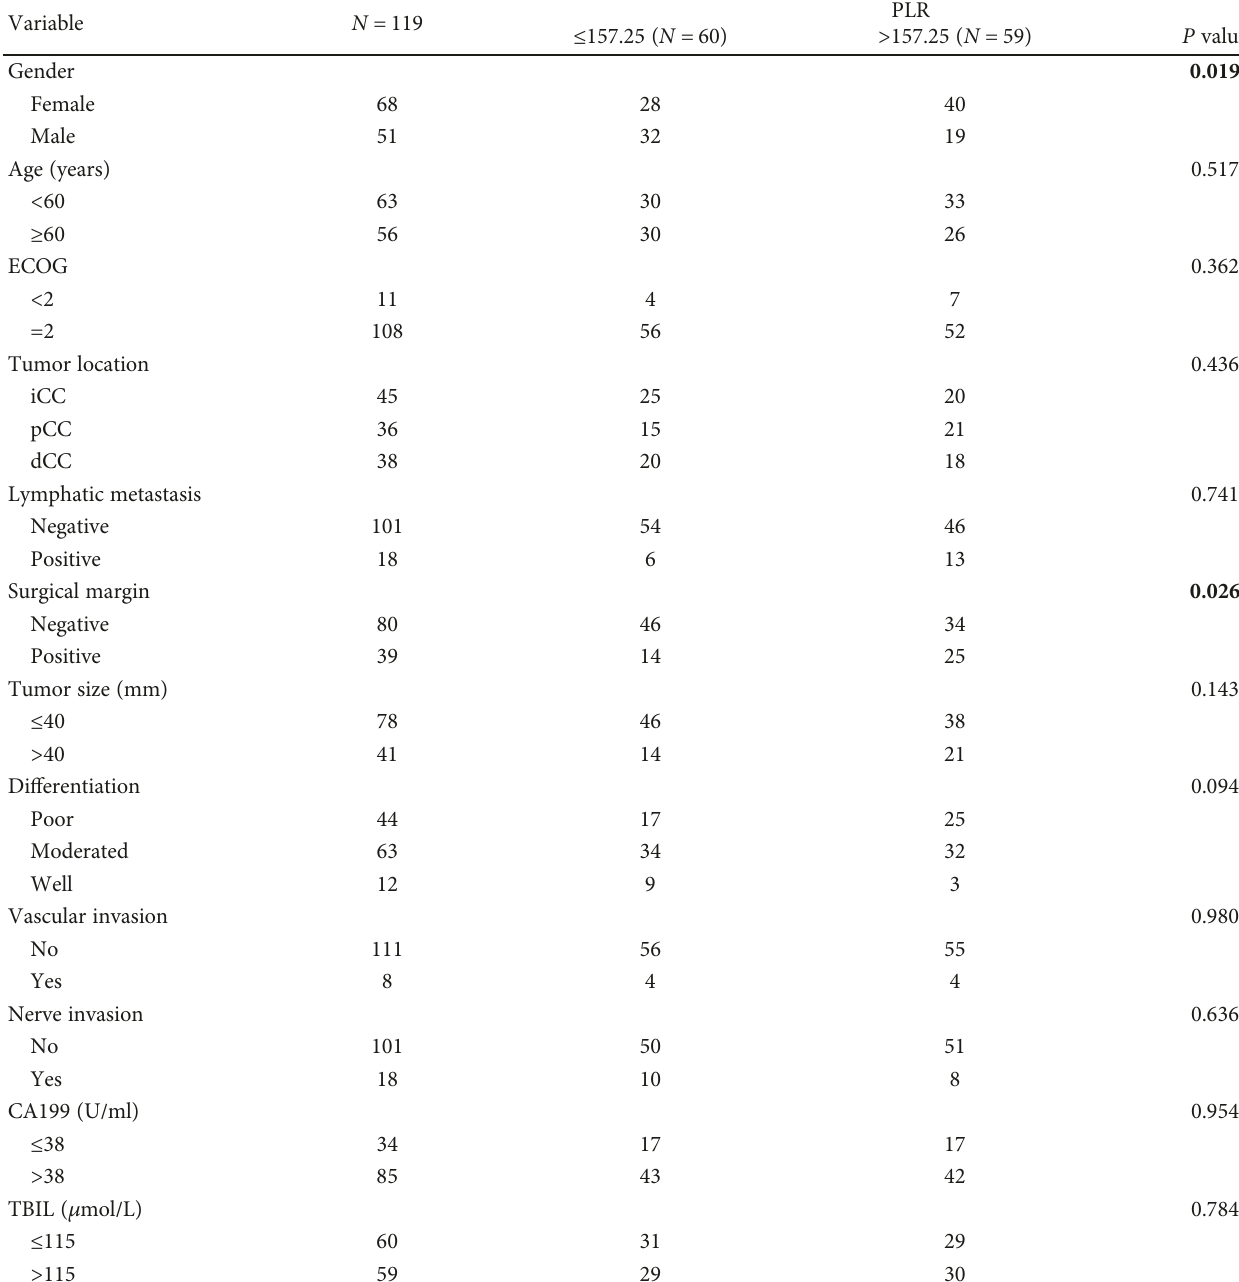
Table 2: Correlation between preoperative serum PLR and clinicopathological characteristics in CCA ( N = 119